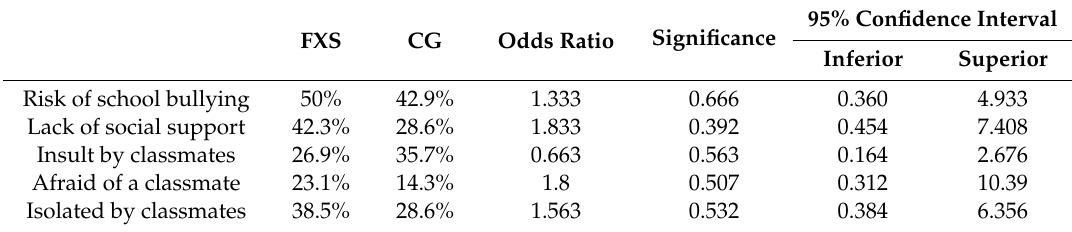
Table 3. Odds ratio of bullying depending on the